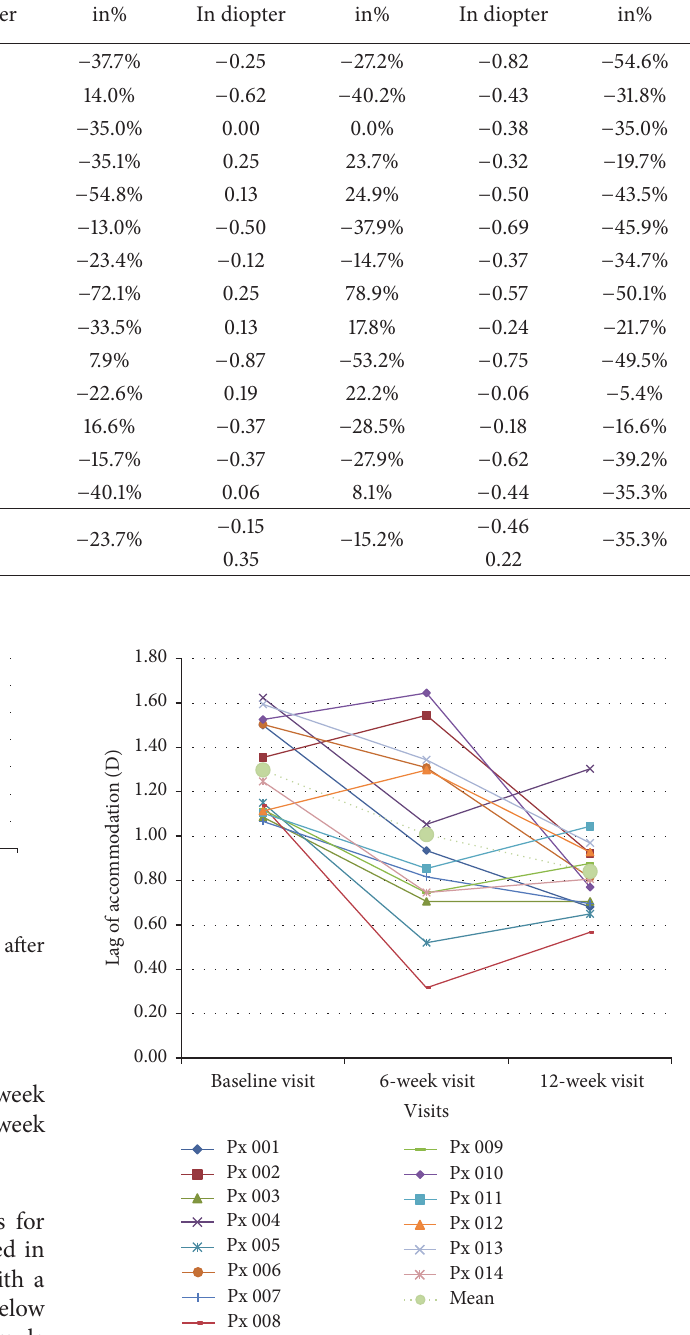
Figure 2: Lag of accommodation over time. The dotted line is the mean data while others are data of individual